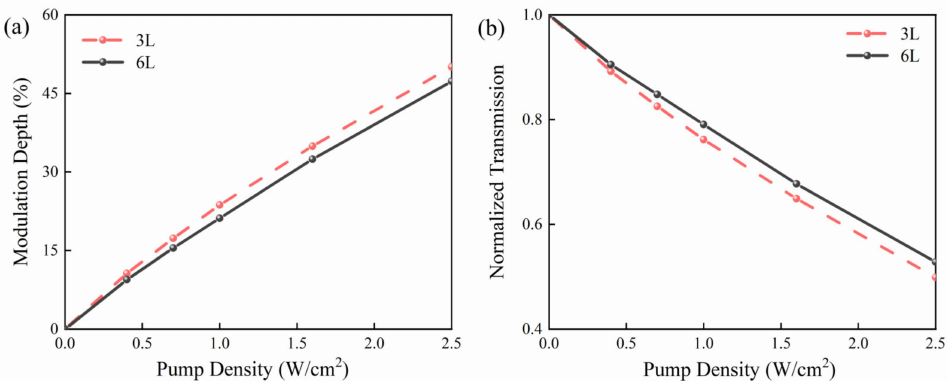
Figure 5. ( a ) Modulation depths of 3L and 6L PtSe 2 devices at different pump power density. ( b ) Normalized transmittance signals at different pump power density of 3L and 6L PtSe 2